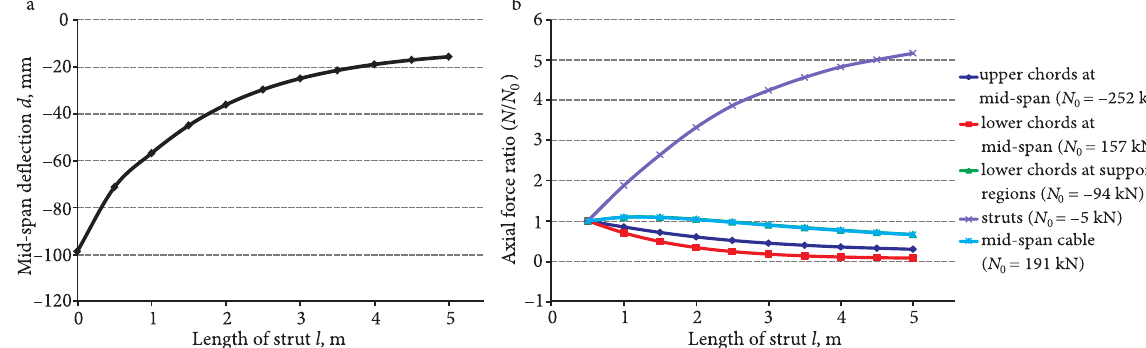
Fig. 4. Variation of mid-span deflection and axial force ratio with space between struts (when struts number is odd): a – mid-span deflection versus the space between struts; b – axial force ratio versus the space between struts